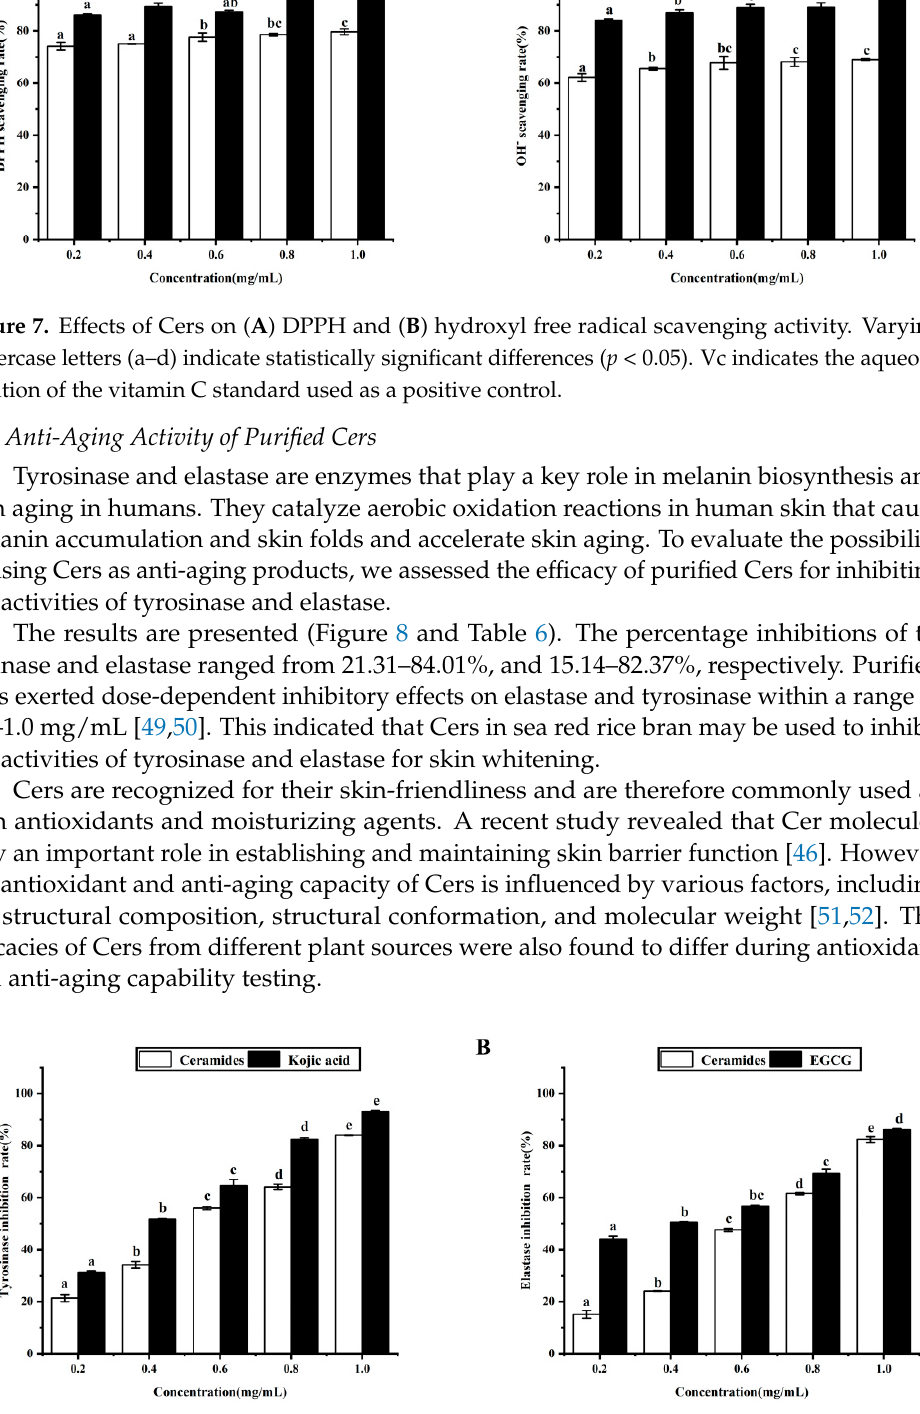
Figure 8. Effects of Cers on ( A ) tyrosinase inhibition and ( B ) elastase inhibition. Varying lowercase letters (a–d) indicate statistically significant differences ( p < 0.05).